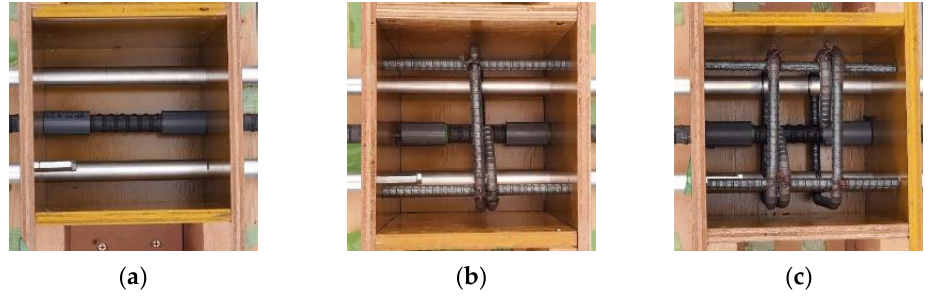
Figure 6. Specimen framework: ( a ) series S0; ( b ) series S1; ( c ) series S2.